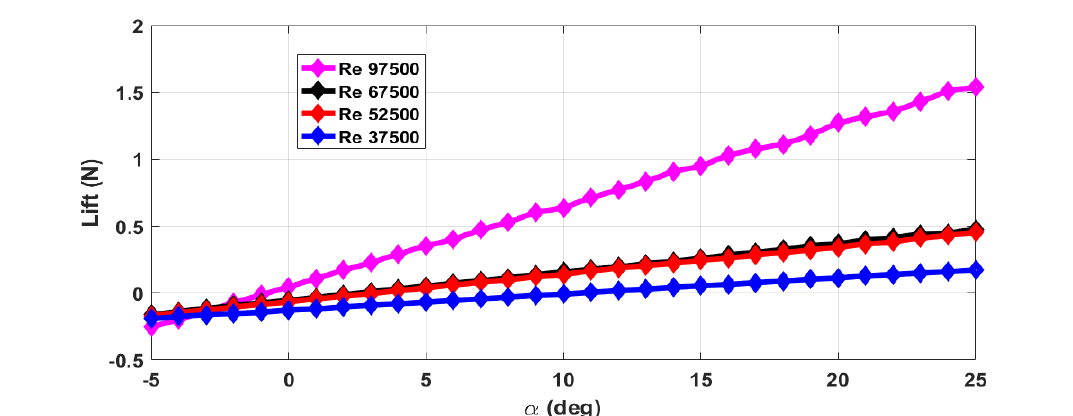
Figure 5. Lift force for − 25 ◦ elevator deflection and zero propeller RPM.